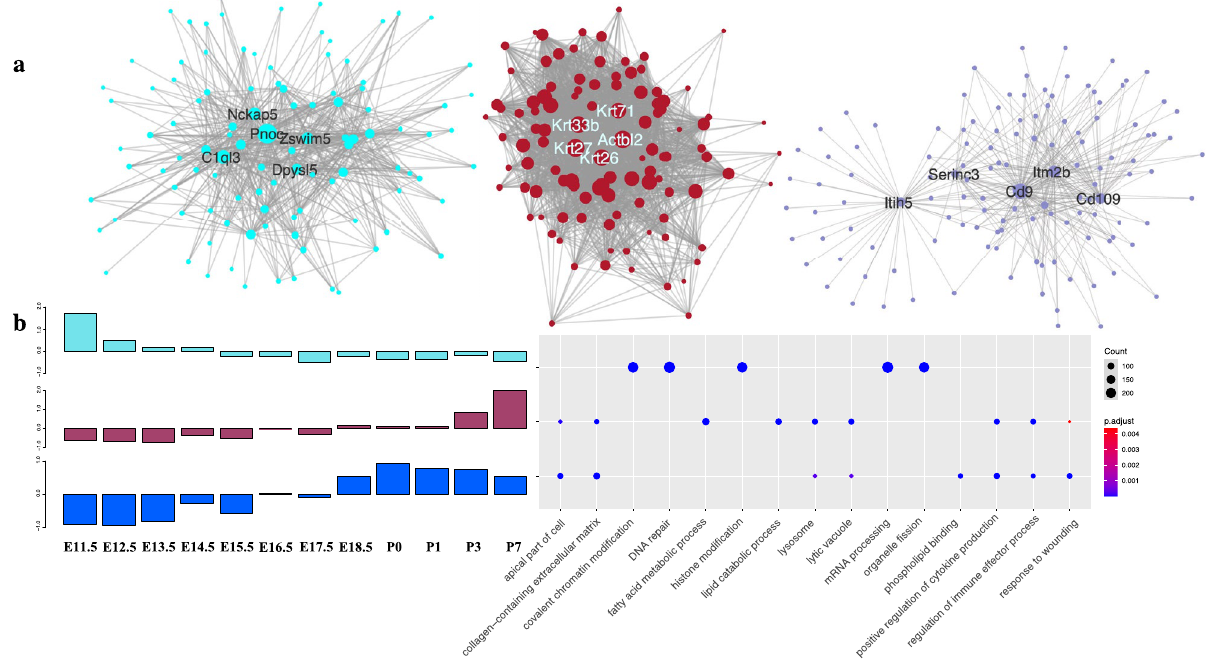
Figure 4. The network structure, temporal expression patterns, and enriched GO terms of top co-expression modules. ( a ) Three networks from Module Turquoise, brown and Blue were visualized by Cytoscape. The circle size was mapped based on edge numbers. Top five genes with the highest connectivity were labelled. ( b ) Relative gene expression and their GO enrichment result. The left panel is the relative gene expression of each module. The TPM value was Z-score normalization and calculated average expression per stage; the right figure is the enrichment GO terms for each